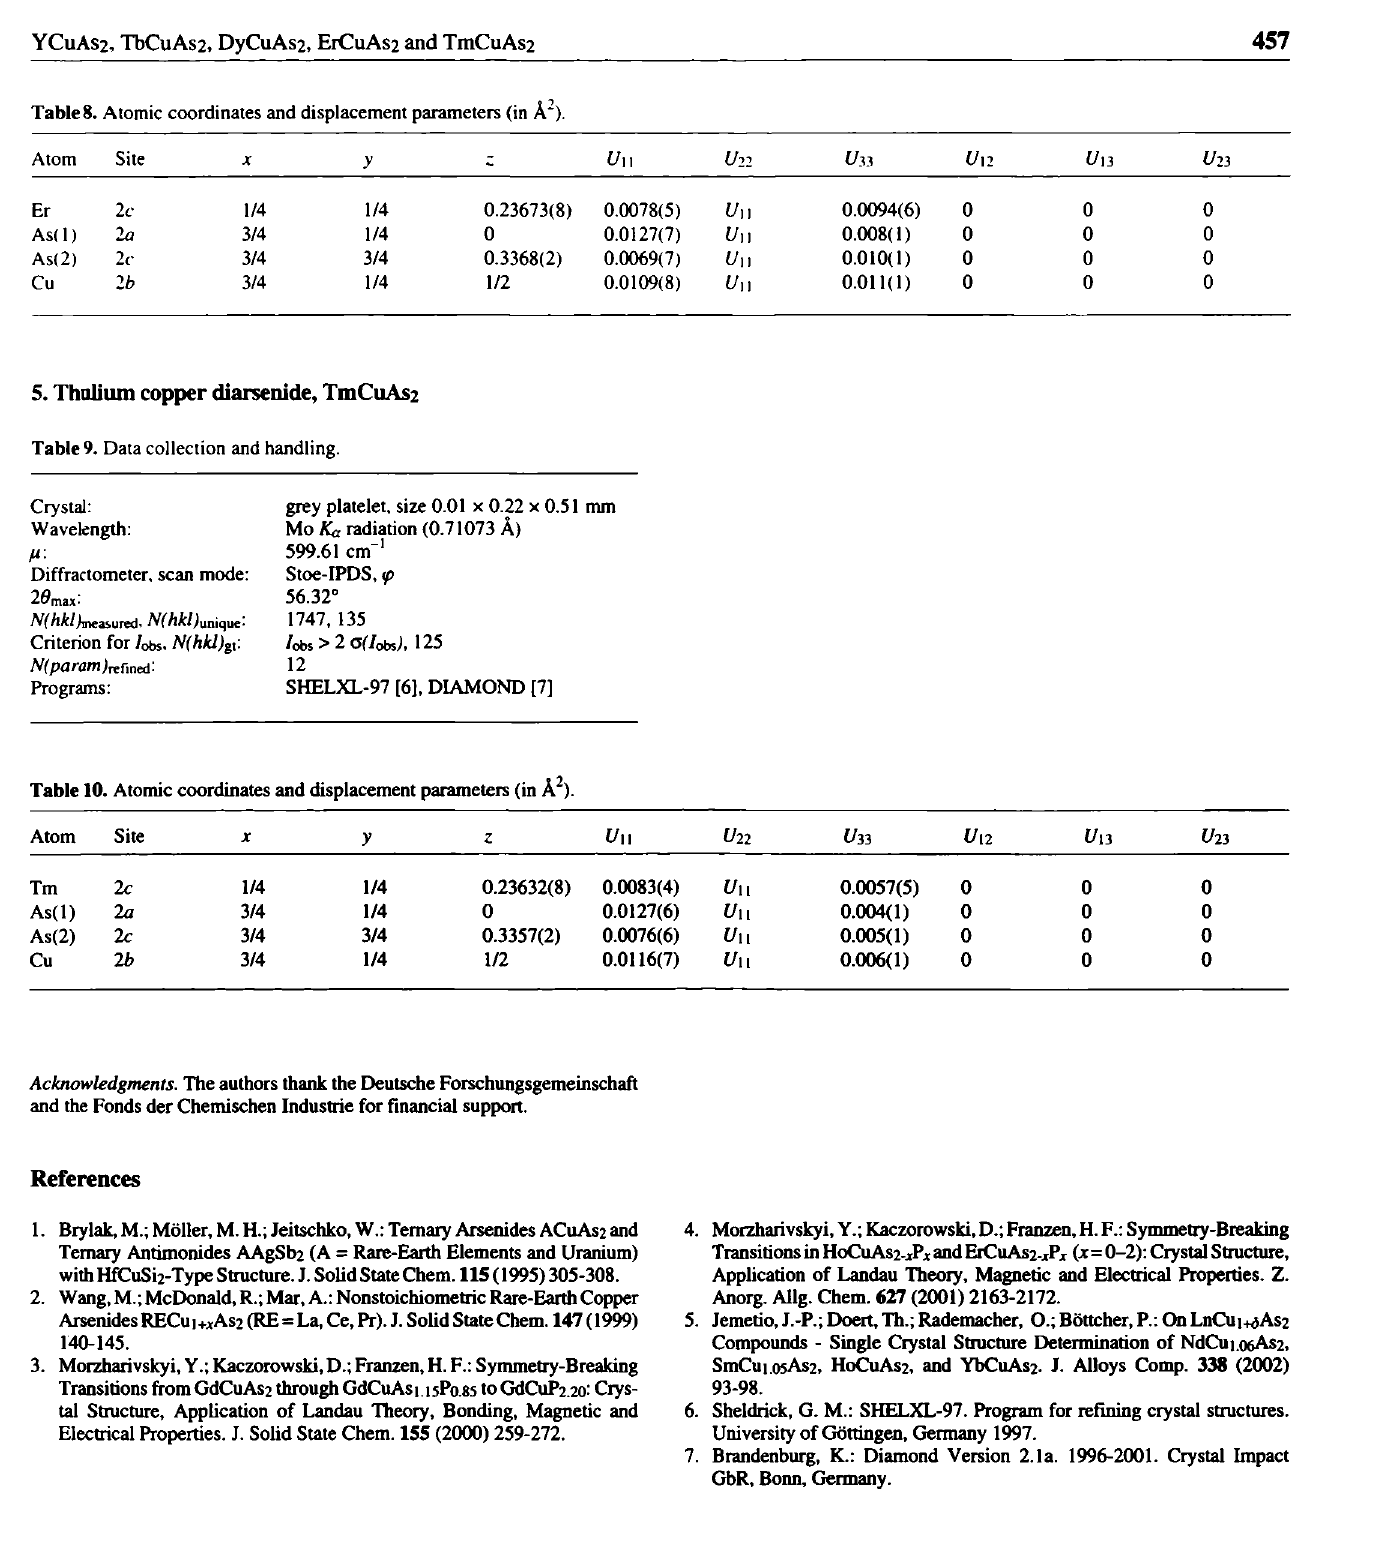
Table 8. Atomic coordinates and displacement parameters (in Â 2 ).